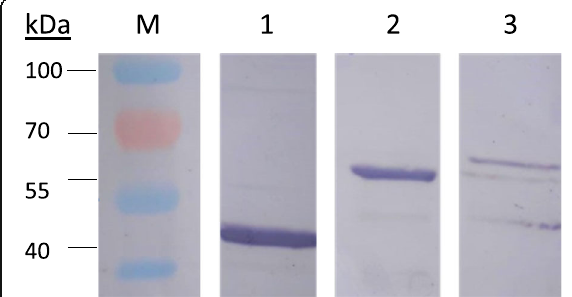
Fig. 3 Western blot analysis of chitinase proteins of Serratia marcescens , AcNPV and CpGV. M, marker (prestained). 1, S. marcescens -ChiC protein (50 kDa); 2, AcNPV-Chi (63 kDa); and 3, CpGV-Chi (68